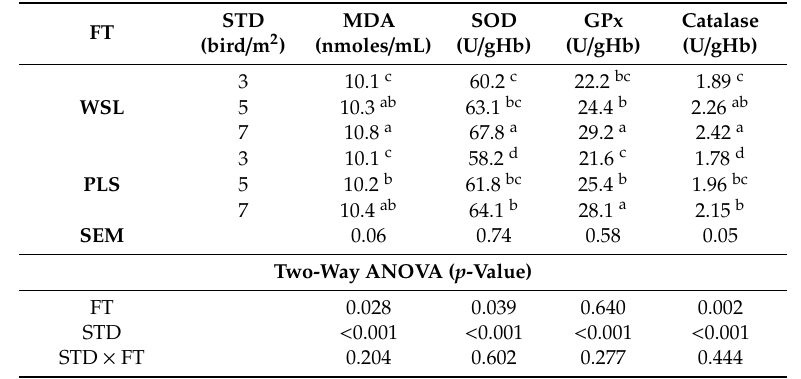
Table 5. E ff ects of stocking density (STD) and flooring type (FT) on anti-oxidative activity of Pekin ducks at 49 days of